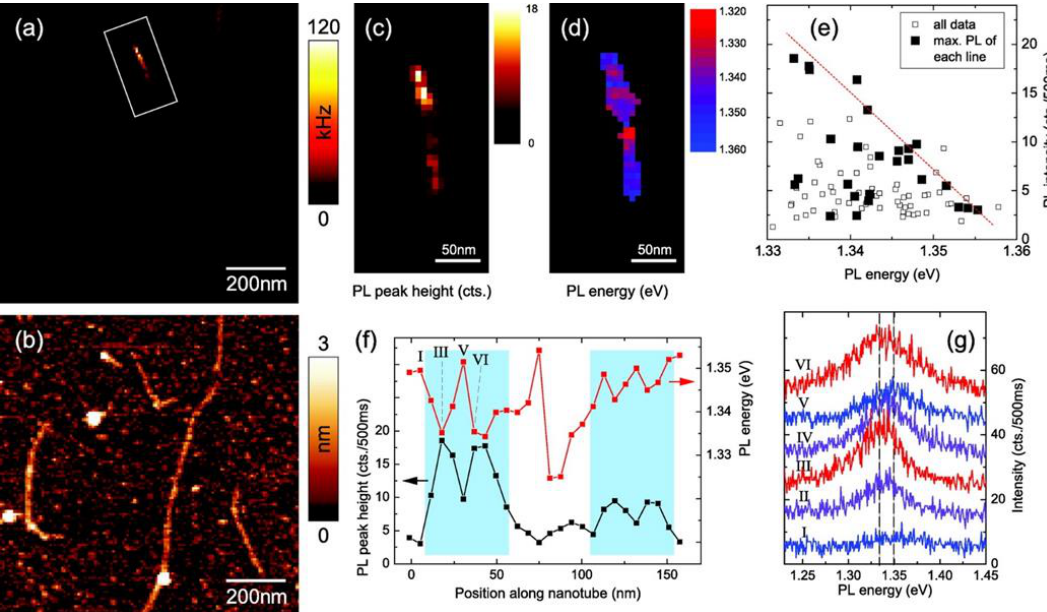
Figure 6. Exciton localization in a 160 nm long (9,1) SWNT. ( a , b ) Near-field photoluminescence (PL) image and corresponding topography showing several luminescent nanotubes; ( c , d ) Maps of the PL intensity and energy derived from a subsequent spectroscopic image of the area marked in panel ( a ) by peak fitting the recorded spectra at each image pixel; ( e ) Correlation between PL intensity and energy for all image pixels (open squares), with the brightest pixel of each image line being highlighted (filled squares) to account for the influence of finite spatial resolution (see text); ( f ) PL intensity and energy plotted along the nanotube; ( g ) Near-field spectra from six adjacent positions ( I – VI ) along the nanotube, equally spaced by 6.5 nm and marked in panel ( e ). The PL energy shifts by up to 15 meV (range indicated by the two dashed lines) between two neighboring positions (reprinted from reference [92] with permission).